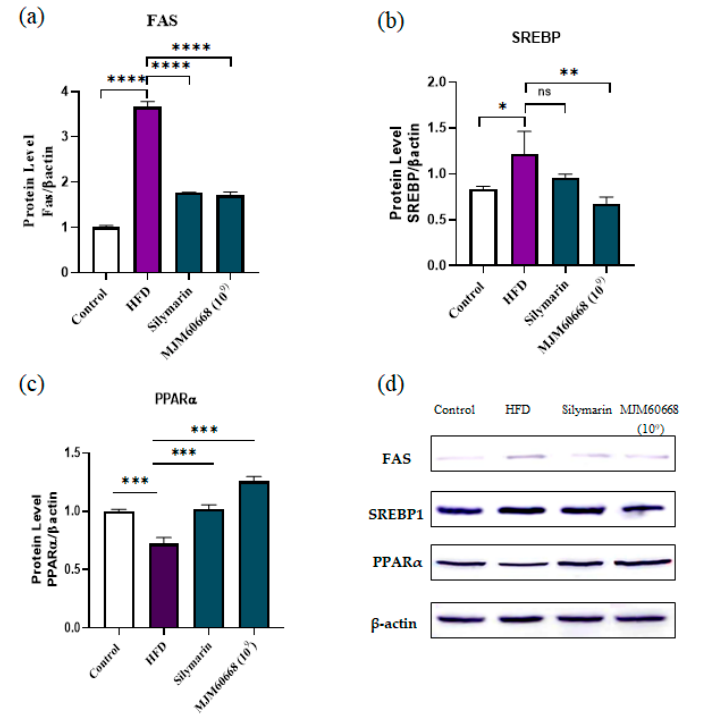
Figure 8. L reuteri MJM60668 decreases FAS and SREBP and increases PPAR α expression in liver at protein level. ( a ) protein expression of FAS in mice liver, ( b ) protein expression of SREBP in mice liver. ( c ) protein expression of PPAR α in mice liver. ( d ) Images for western blot band. Data represented as mean ± S.E.M of three independent experiments. n = 4. ns = non-significant differences * p < 0.05 compared with HFD group, ** p < 0.01, *** p < 0.001, **** p < 0.0001 compared with HFD